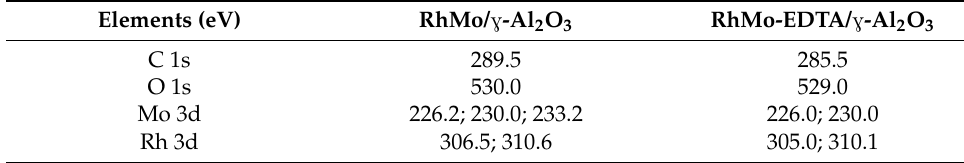
Figure 3. XPS spectra for ( a ) RhMo/ ɣ -Al 2 O 3 survey spectrum with different elemental contributions, ( b ) S 2p, ( c ) Rh 3d, ( d ) Mo 3d. Table 3. Binding energies determined in XPS experiments for RhMo/Al 2 O 3 and RhMo-EDTA/ G -Al 2 O 3